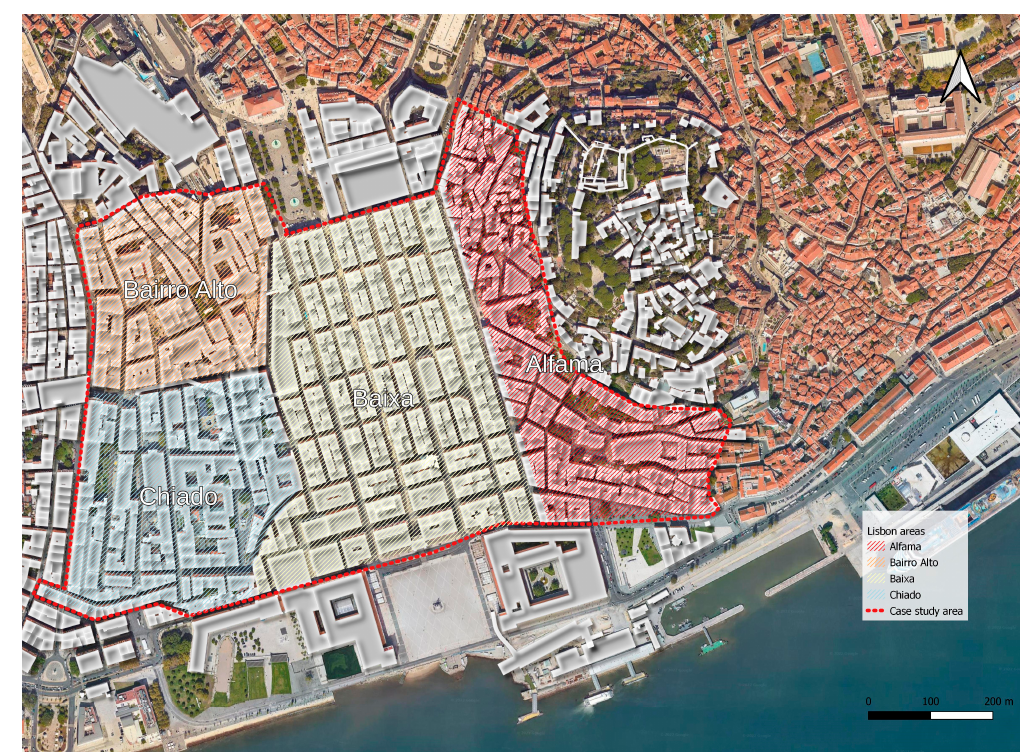
Figure 4. Case study